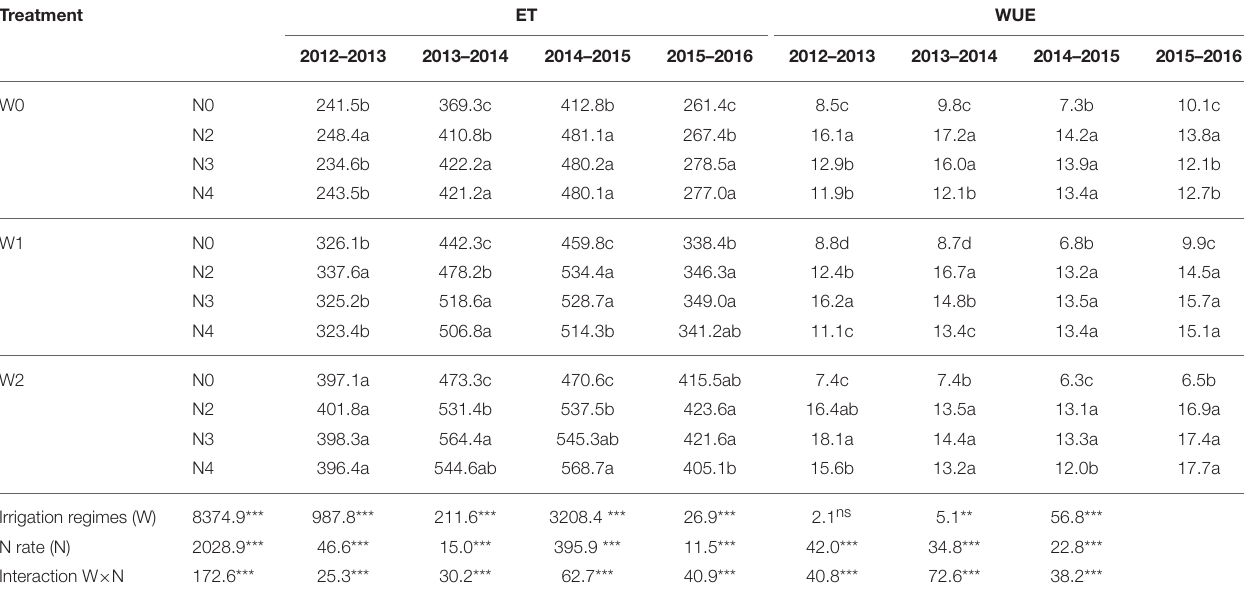
TABLE 4 | Effects of irrigation and nitrogen regimes on evapotranspiration (ET; mm) and water use efficiency (WUE; kg ha − 1 mm − 1 ) of winter wheat for the 2012–2013 to 2015–2016 growing seasons.